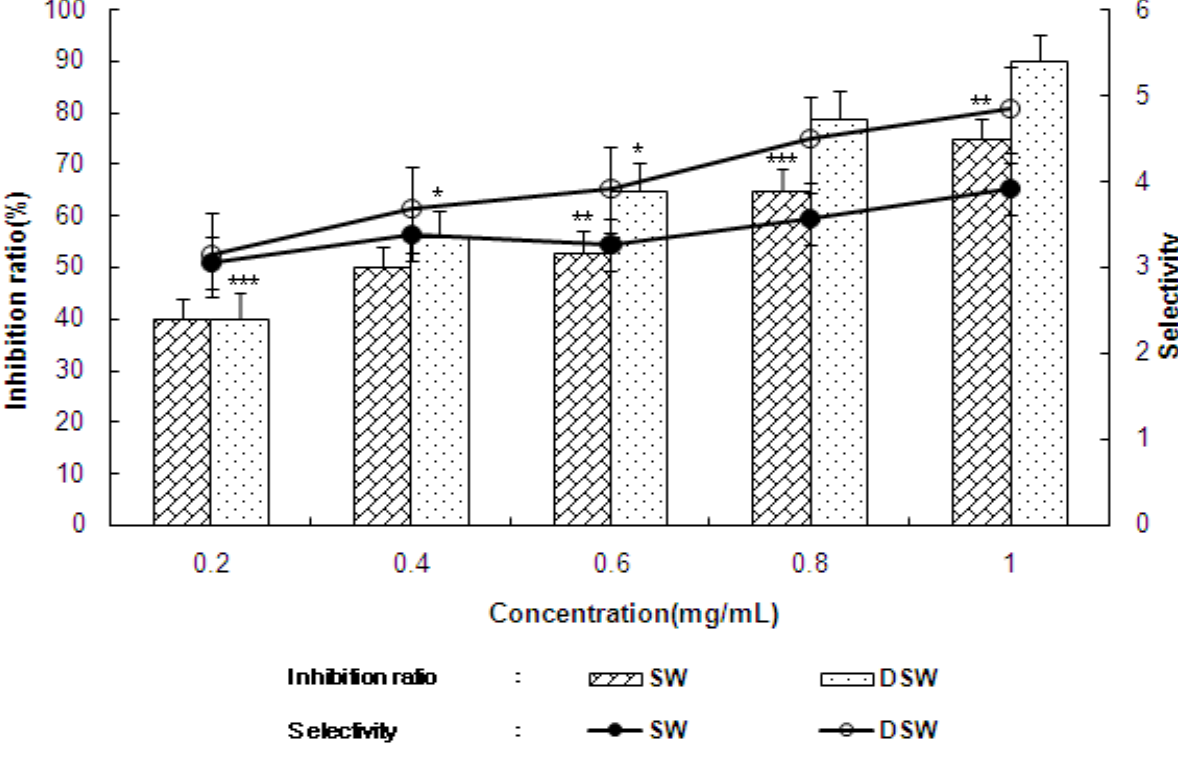
Figure 2. Inhibition of human stomach adenocarcinoma (AGS) (bar chart, percent) and selectivity (line chart) after adding 1.0 mg/mL of the extract of S. maxima cultivated in SW and DSW. Mean ± S.D. from triplicate separated experiments are shown. Each value were compared with the control at * p < 0.01, ** p < 0.005, *** p < 0.001 by Student t -test. (SW: seawater, DSW: deep-sea